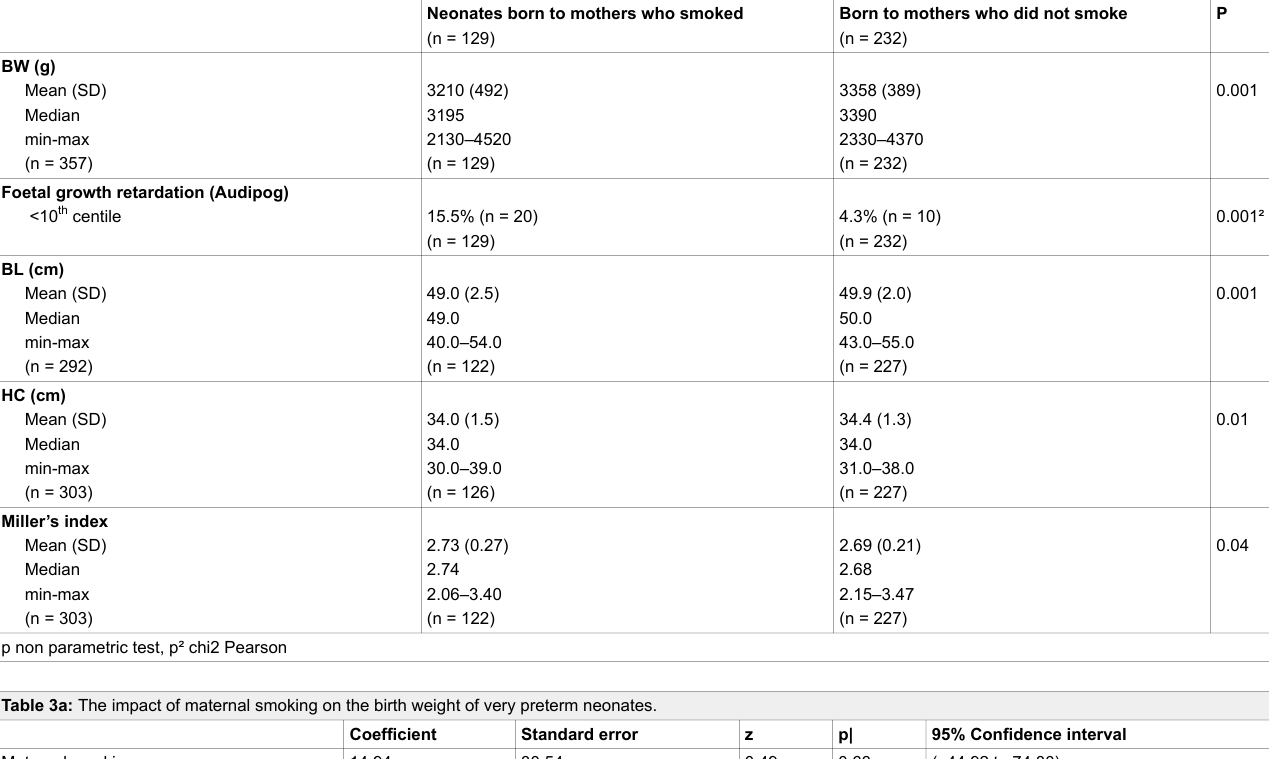
Table IIb: Comparison of fœtal growth parameters in term born infants (GA 37–42 weeks) born to smokers versus those born to non smokers.